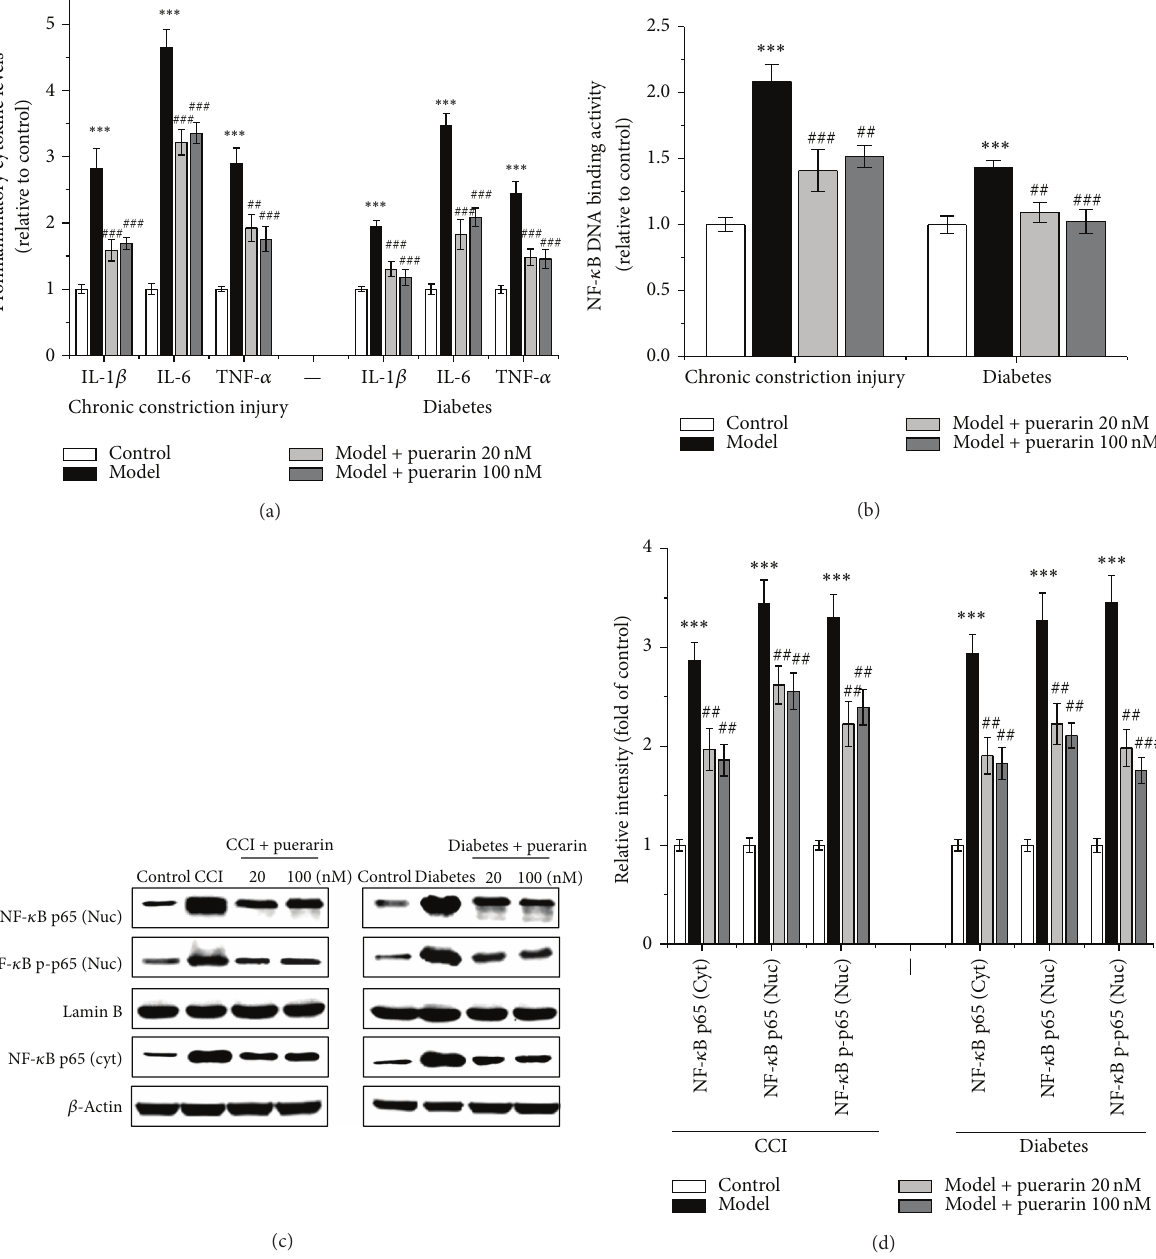
Figure 5: The effects of puerarin on CCI- and diabetes-induced proinflammatory cytokines overexpression (a) and NF- 𝜅 B overactivation ((b), (c), (d)) on the 11th day after CCI surgery, and on the 27th day after streptozotocin injection in rat spinal cord. Data are presented as mean ± SEM. CCI: chronic constriction injury; Cyt: cytoplasmic; Nuc: nuclear. ∗∗∗ 𝑃 < 0.001 , CCI and diabetes models versus control; # 𝑃 < 0.05 , ## 𝑃 < 0.01 , ### 𝑃 < 0.001 , puerarin versus CCI and diabetes models (one-way ANOVA with post hoc LSD 𝑡 -test). Each group consisted of 6–10